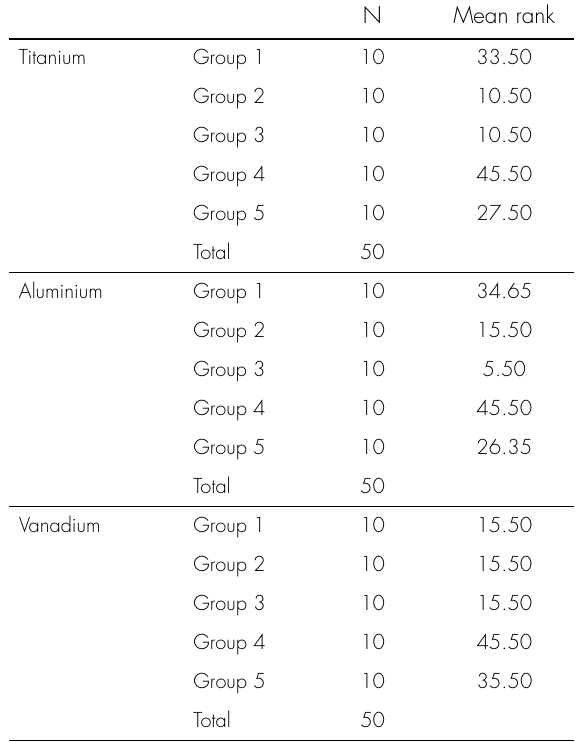
limits (BDL) in Groups 2 and 3. Vanadium showed below detectable limits (BDL) in Groups 1, 2 and 3. Table IV indicates that the multiple comparisons of means of Ti, Al and V release between the five groups were statistically highly significant at p values of < 0.01. The Mann-Whitney test for the bi-variate Table V. Mann-Whitney U test for bi-variate comparison of Ti, Al and V release between groups.